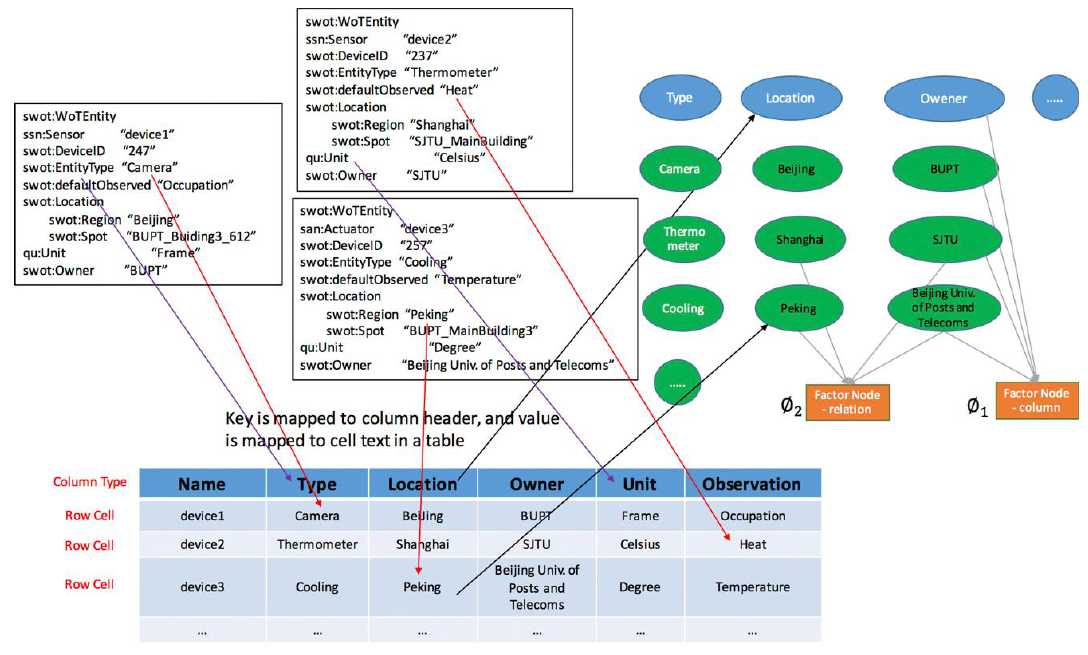
Figure 3. WoT metadata is semi-structural relational data with key-value pairs. The EL Annotator can transfer the WoT metadata into tabular data and perform entity linking tasks. EL tasks use a probabilistic graphical model to jointly inference the linking and mapping.